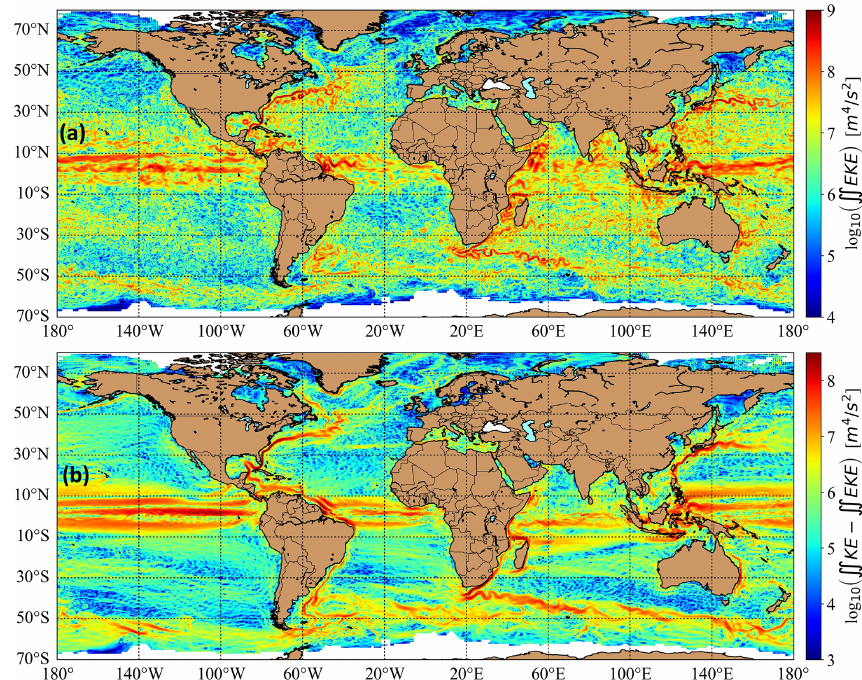
Figure 1. Snapshot of the global geostrophic flow field on a randomly chosen day (23 September 2018) from the AVISO data bank (Aviso, 1993–2018; Taburet et al., 2019). Color coding is in a logarithmic scale for better visualization; note the different ranges. (a) Integrated (u (cid:48) 2 g + v (cid:48) 2 g ) (units: m 4 s − 2 ). Velocity anomalies eddy kinetic energy for each grid cell of 0 . 25 ◦ × 0 . 25 ◦ from geostrophic velocity anomalies 1 2 [ u (cid:48) g ,v (cid:48) g ] are obtained from the AVISO data bank; see Sect. 2.1. (b) The difference between the total kinetic energy from geostrophic velocities (cid:104) 1 (cid:105) (u 2 g + v 2 g ) − 1 (u (cid:48) 2 g + v (cid:48) 2 g ) [ u g ,v g ] and the eddy kinetic energy . Direct [ u g ,v g ] components are determined from sea surface height (SSH) 2 2 data in the AVISO data bank. Integration is performed by multiplying the squared velocity difference by the curvature-corrected cell size measured in square meters (m 2